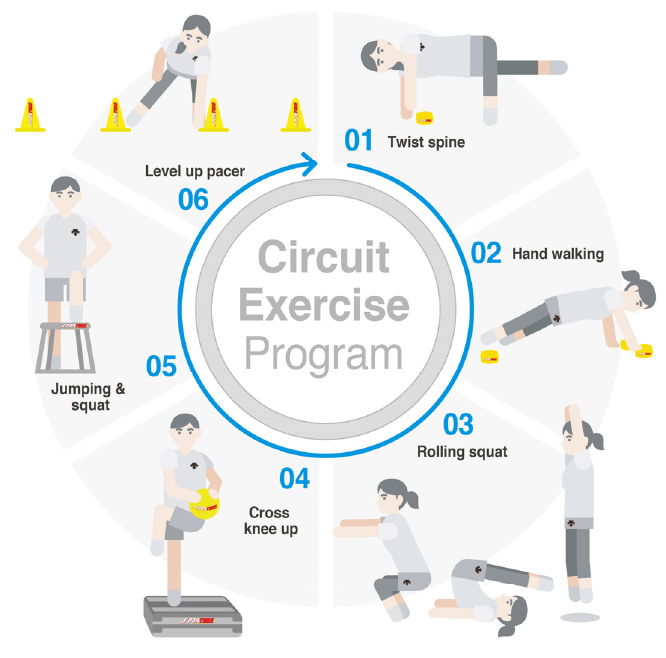
Figure 1. Schematic representation of circuit exercise program.